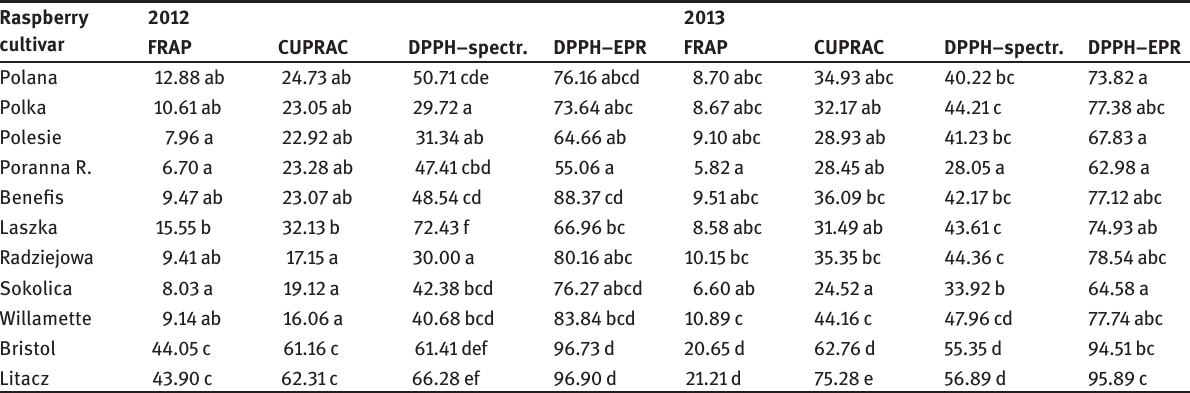
Table 5: Antioxidant activity of the tested raspberry fruits. Raspberry